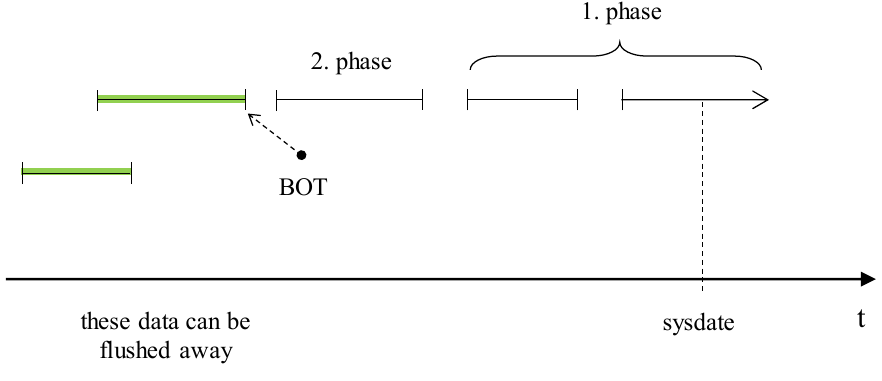
Figure 13. Expired data identification.